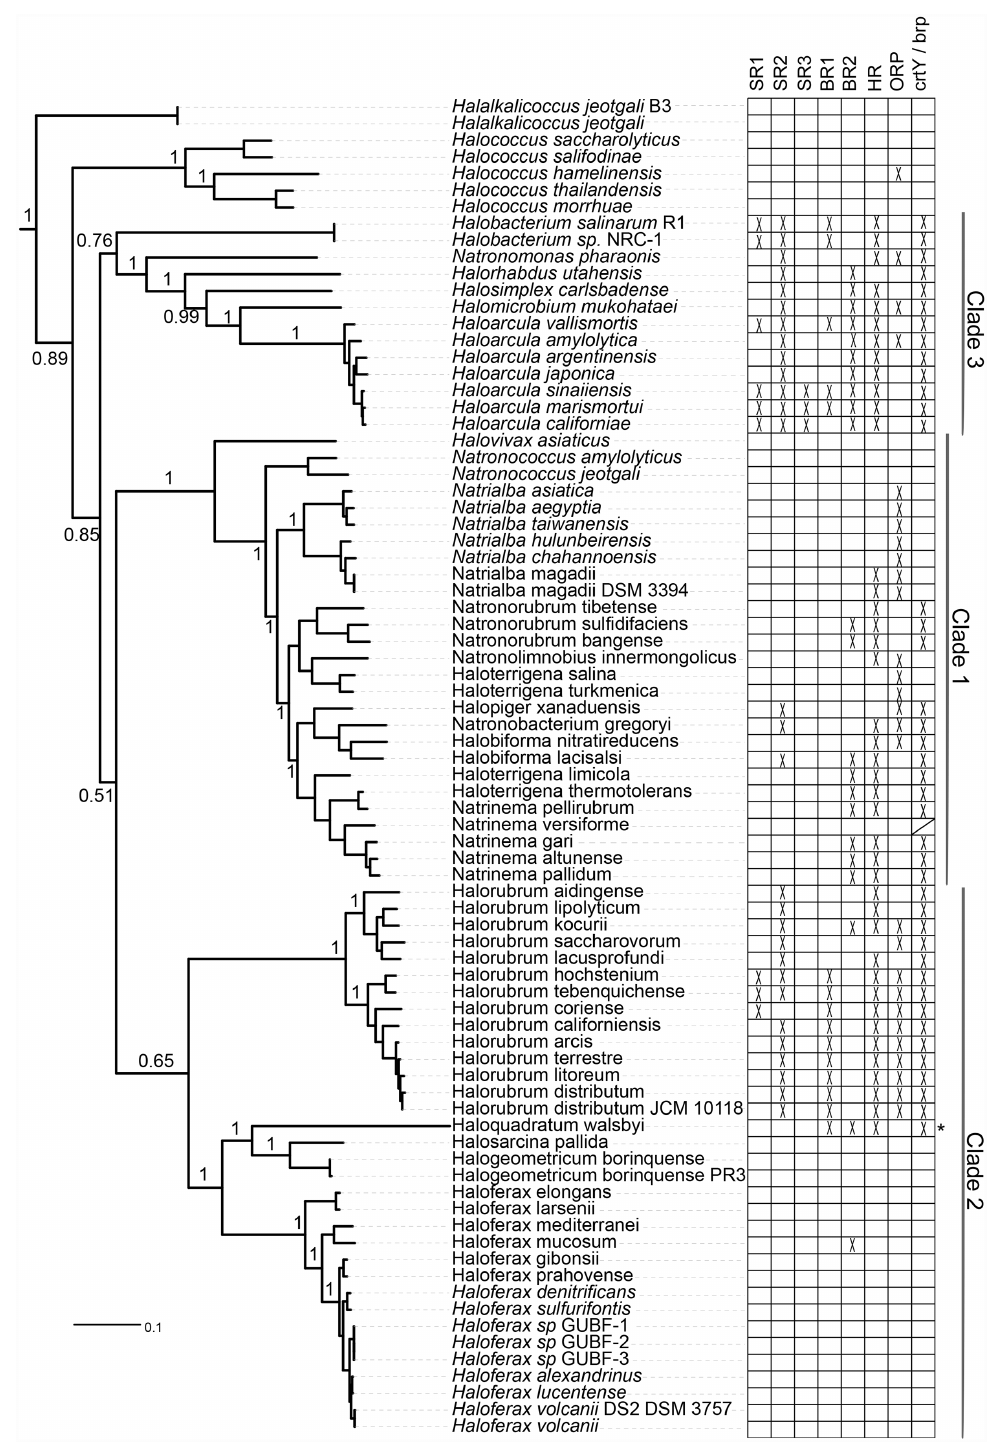
Fig 1. Phylogenetic distribution of opsin classes across the Haloarchaea. Distribution of six previously characterized haloarchaeal opsin families, the putative retinal-free opsins, and the retinal biosynthesis genes crtY and brp are shown superimposed on a multi-marker phylogenetic tree of 80 sequenced haloarchaea (tree published in Becker et al , 2014). SR = sensory rhodopsin, BR = bacteriorhodopsin, HR = halorhodopsin, ORP = retinal-free opsin. Asterisk indicates the presence of middle rhodopsin (MR) [14]. Phylogenetic distribution of crtY and brp are identical except for one species ( Natrinema versiforme ) which has brp but